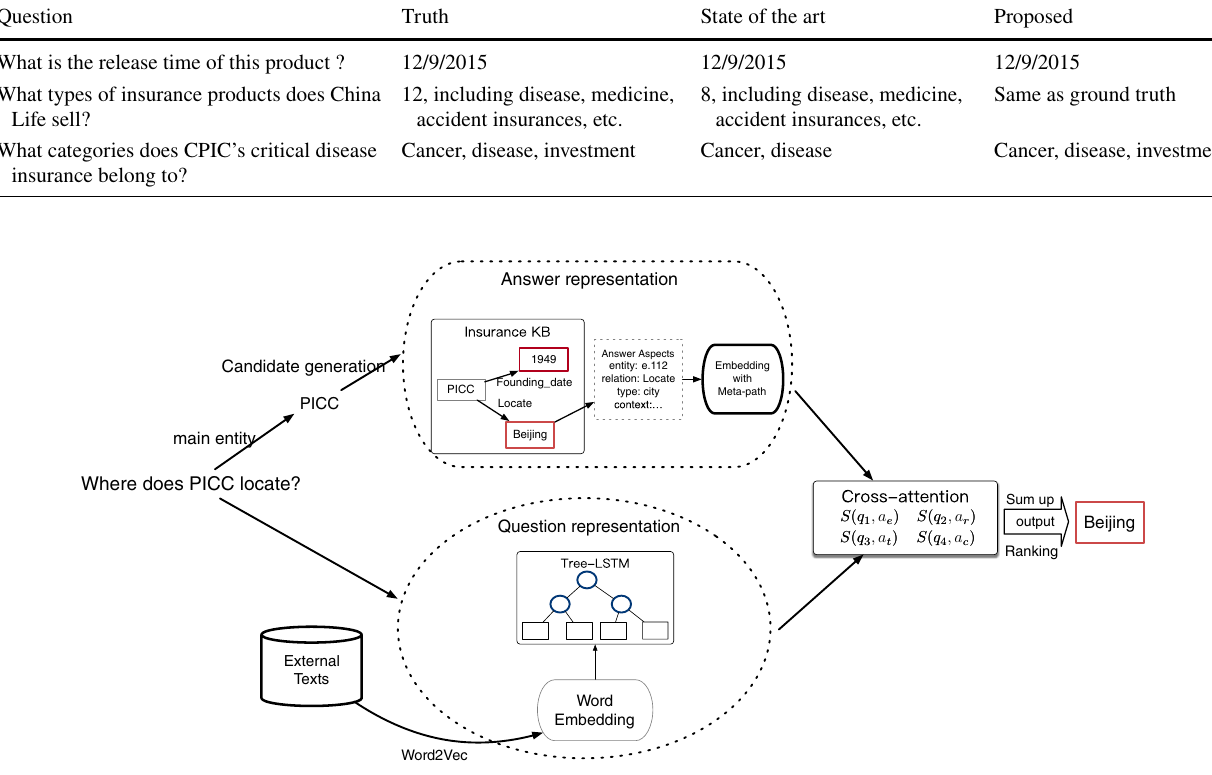
Fig. 1 KG-QA with the help of domain